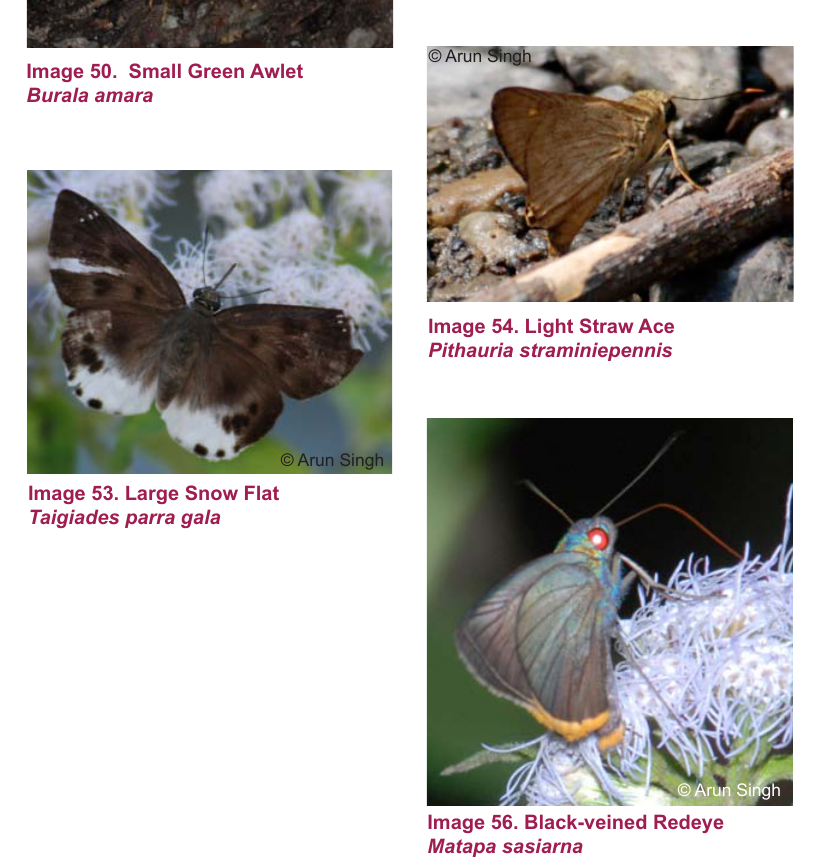
Image 56. Black-veined Redeye Matapa sasiarna